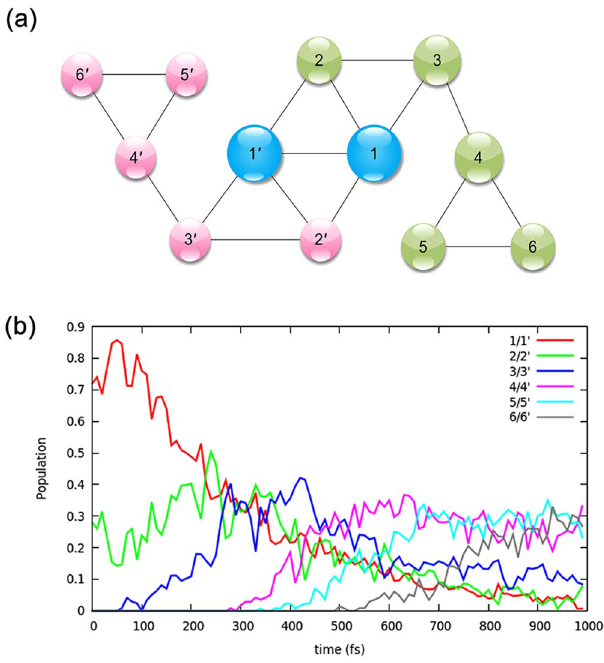
Figure 2. ( a ) The network formed by connecting the meat-stable patterns. The size of the circles reflects the relative number of snapshots in each pattern. ( b ) The time dependent population of each meta-stable pattern. And the meta-stable patterns could be corresponding to the possible free energy basins.